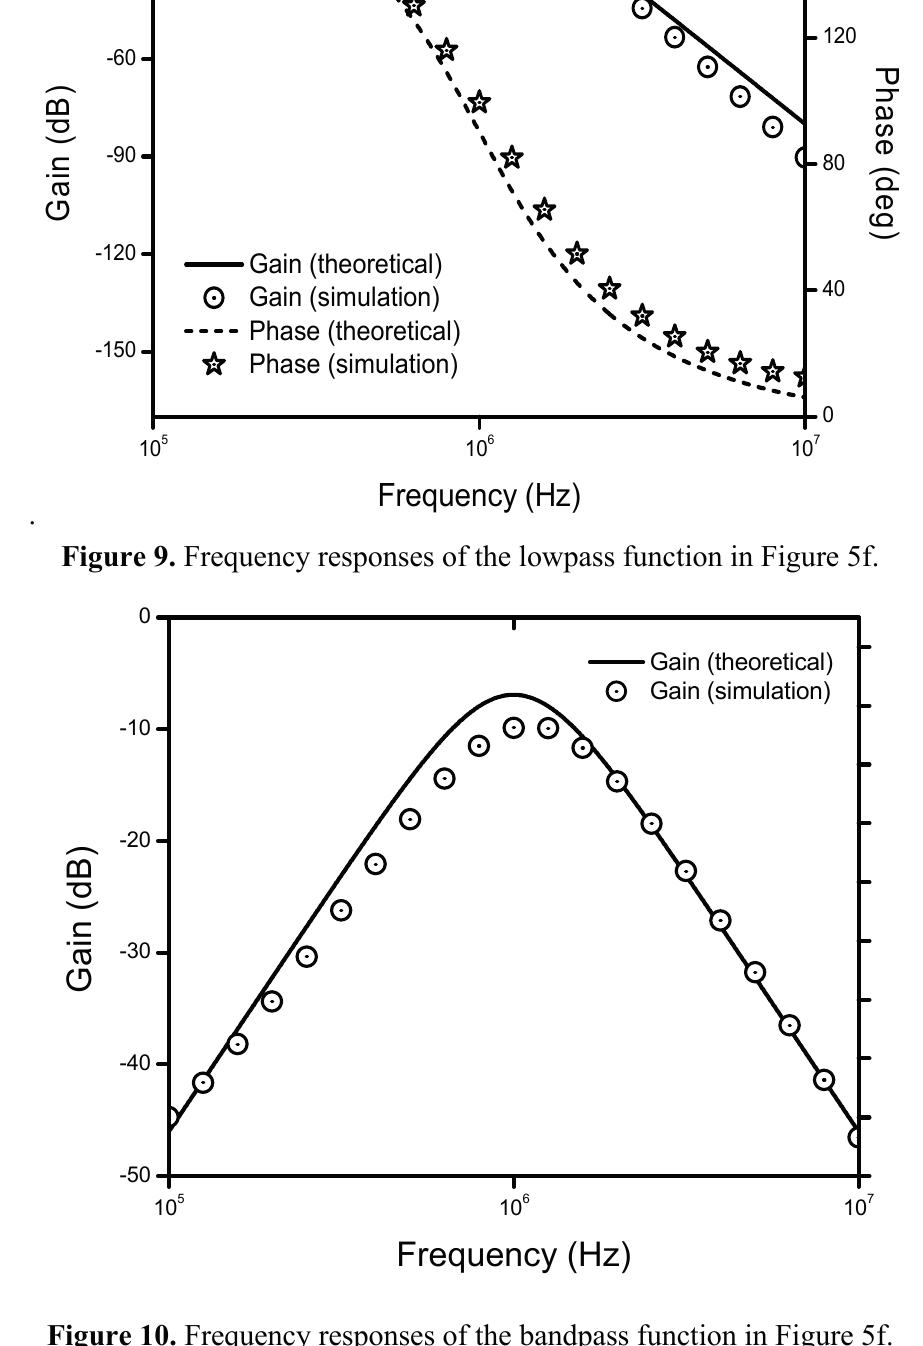
Figure 10. Frequency responses of the bandpass function in Figure